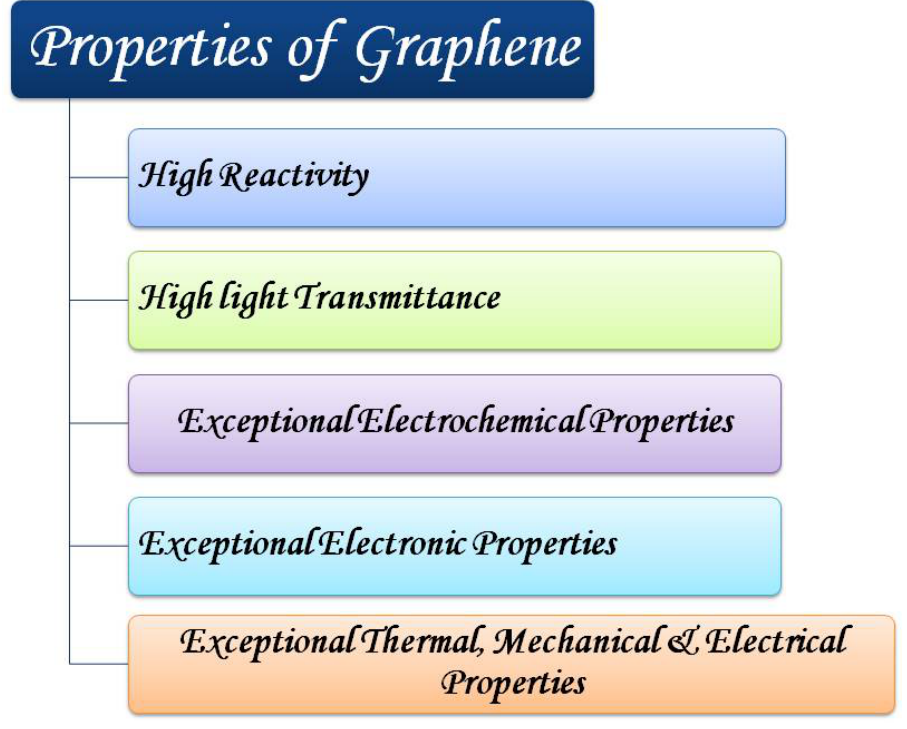
Figure 7. Properties of graphene.